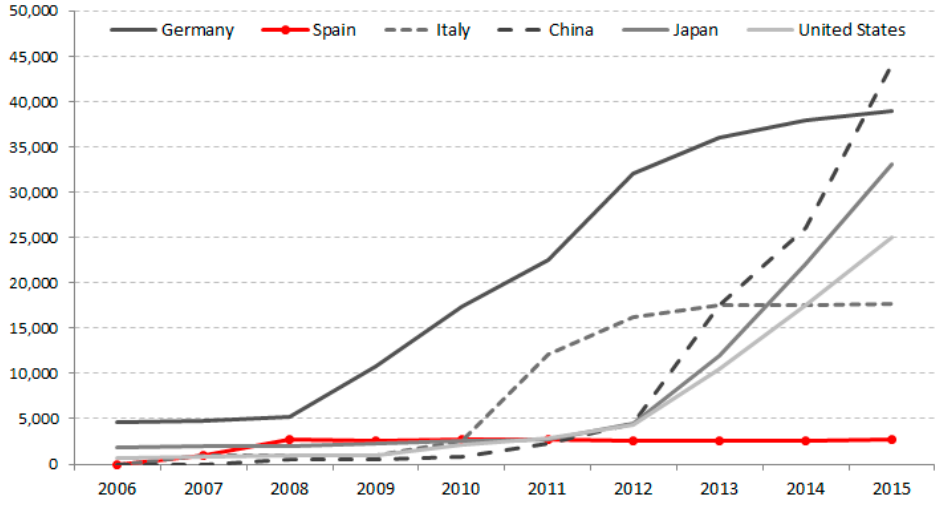
Figure 1. Photovoltaic (PV) potential installed in the world (in MW) [43].